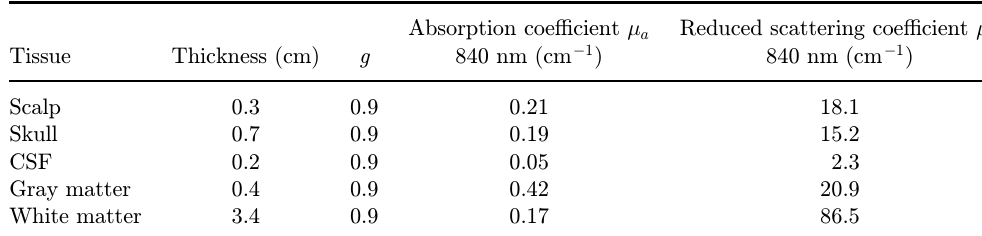
Table 1. The thickness and optical properties of the human adult brain.